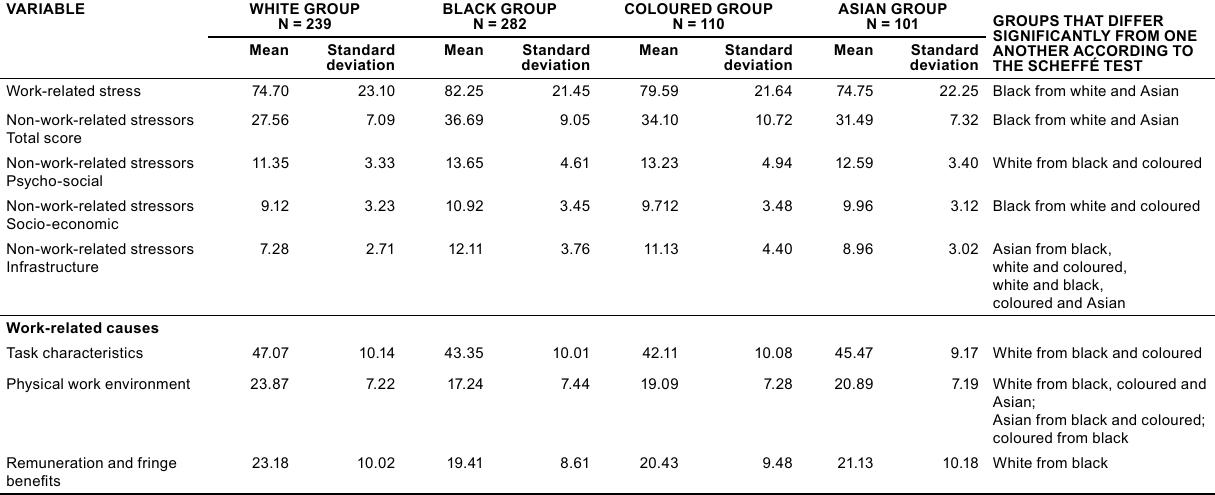
table 2 Specific racial differences with regard to stressors related to and not related to